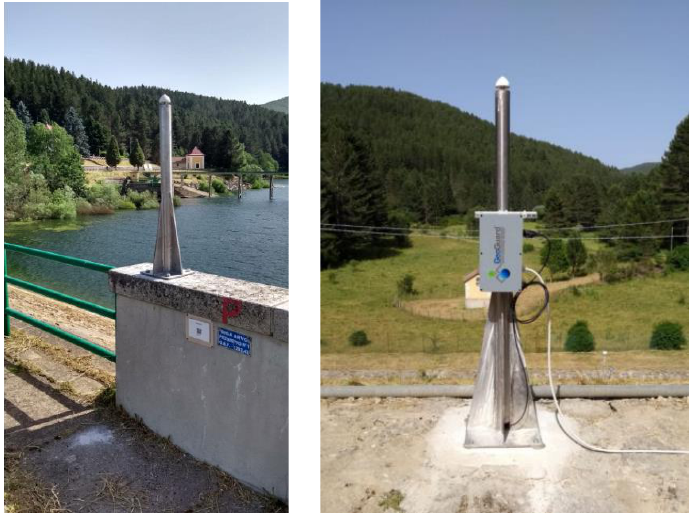
Figure 2. Steel pillars supporting the antennas for points PT3 ( left ) and PT4 ( right ). The other points are materialized with the same kinds of structures.